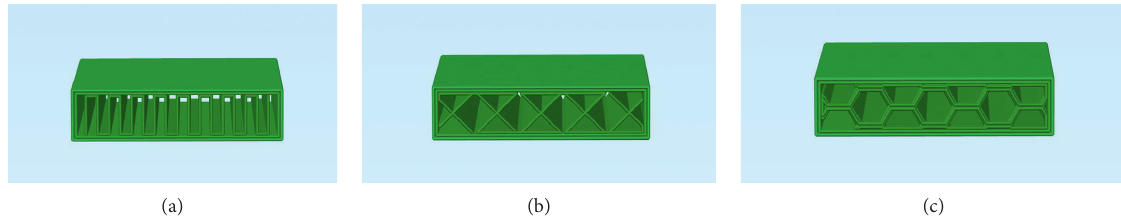
Figure 1: 3D models of different structures of load bearing board: (a) vertical supporting structure, (b) oblique square grid supporting structure, and (c) honeycomb grid supporting structure.